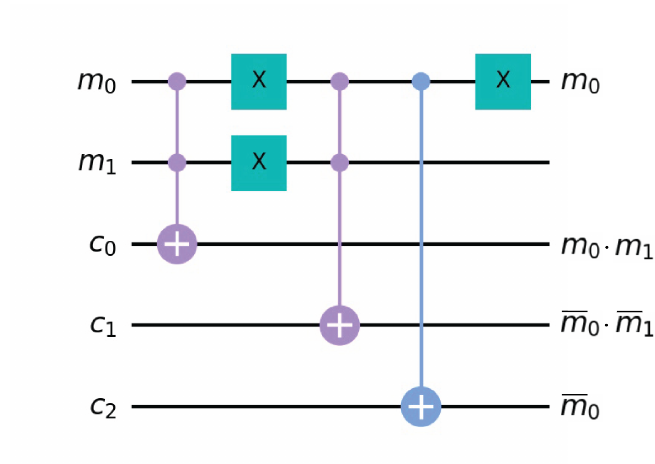
Figure 16. Circuital schema of the 2-4 decoder. The gates are arranged as to compute each of the individual components of the logic of expression (19), with the outputs being labeled on the right of the corresponding qubit wire they are stored to.